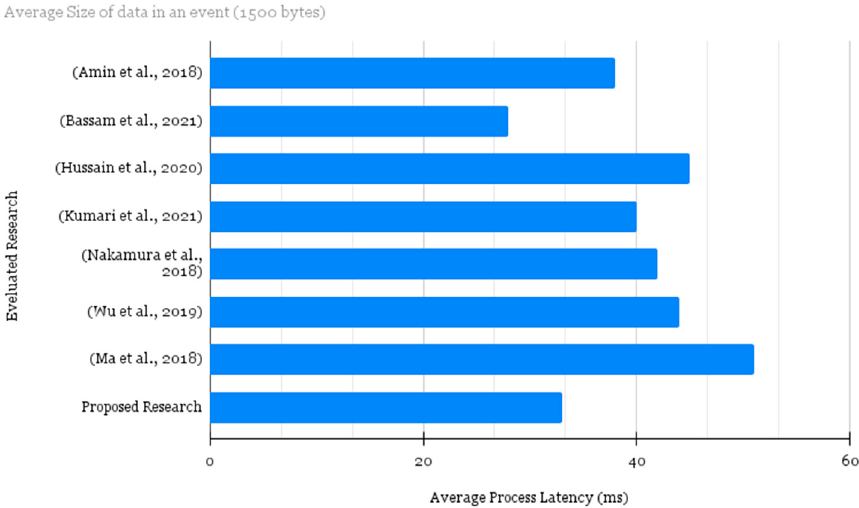
Figure 10. Variable latency time for events of varying sizes (KB).